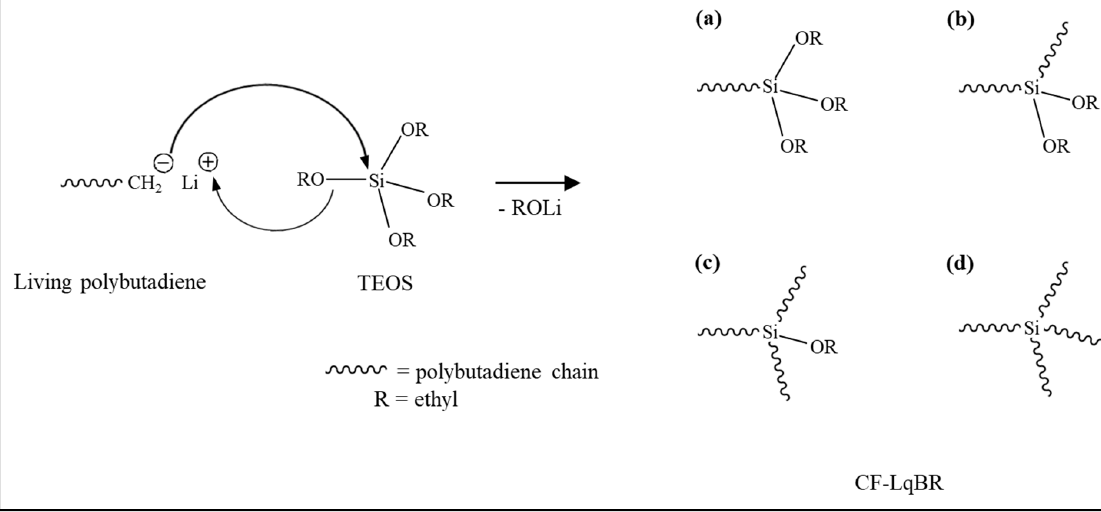
- 2.4.2. Radical Polymerization The polymerization of 1,3-butadiene was performed in a high-pressure stainless-steel reactor (1 L) with a stirrer. First, the reactor was charged with 0.529 g of silane azo initiator and 416 g of THF, and purged with nitrogen gas. Next, 83.3 g 1,3-butadiene (measured in a small chamber) was injected into the reactor under a nitrogen pressure of 4 bar. The polymerization was carried out for 48 h at a temperature of 70 °C. After the reaction, the reaction mixture was cooled, and the remaining butadiene was vented from the reactor. THF was removed using rotary evaporation to concentrate the polymer solution. To re- move the residual initiator, the solution was poured into ethanol to precipitate the poly- mers. Finally, the polymers were collected by centrifugation. The propagating polymer chains can terminate in three ways: coupling, dispropor- tionation, and chain transfer. If there is no chain transfer agent, the polymer chains termi- nate by coupling and disproportionation. In the case of butadiene, it has been reported that termination occurs by coupling [29,30]. Therefore, we synthesized telechelic poly- butadiene with triethoxysilane terminal groups using a free radical azo initiator contain- ing triethoxysilyl groups (Scheme 5).